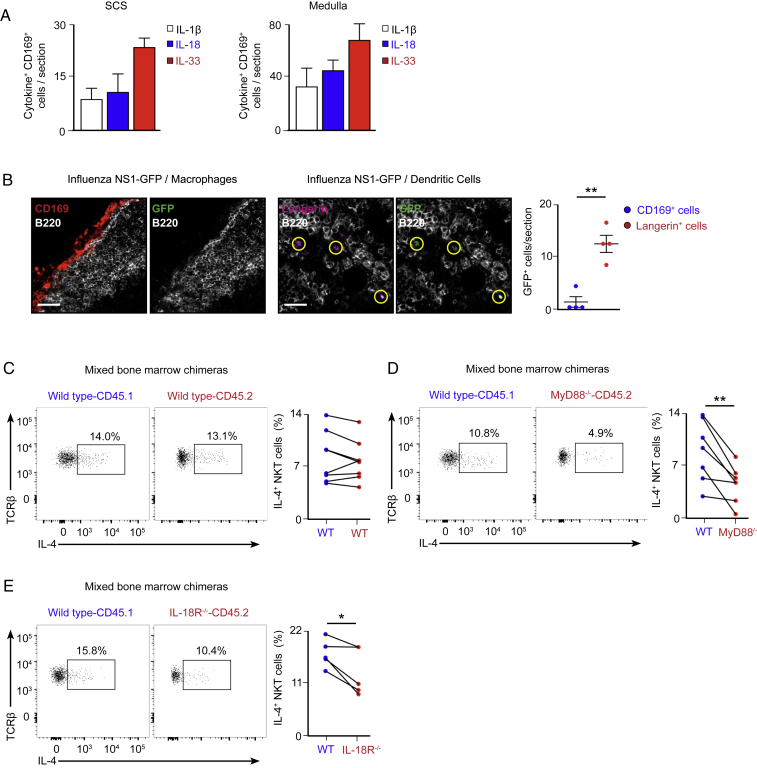
Intrinsic Role of MyD88 and IL-18R in NKT Cell Production of IL-4, Related to Figure 6(A) Quantification of IL-1β+, IL-18+ and IL-33+ cells in the SCS and medullar areas from the images shown in Figures 6C and 6D.(B) Confocal microscopy of mediastinal lymph nodes from wild type mice that were infected with 200 PFU of PR8 NS1-GFP and sacrificed after 3 days. Sections were stained with antibodies to CD169 (red), B220 (gray) and Langerin (magenta). Scale bars, 60 μm. Quantification of GFP+ cells is shown in the right chart.(C–E) Flow cytometry analysis of chimeric mice that were generated by transferring a 1:1 bone marrow mixture of wild type (CD45.1+) and (C) wild type (CD45.2+), (D) MyD88−/− (CD45.2+) or (E) IL-18R−/− (CD45.2+) to sub-lethally γ-irradiated CD45.1 recipient mice. Eight weeks after bone marrow transplant, mice were infected with 200 PFU of influenza virus and mediastinal lymph nodes were harvested after further 3 days. Flow cytometry panels show the production of IL-4 by CD45.1+ and CD45.2+ NKT cells in the different sets of chimeras. Dot graphs show the quantification of IL-4+ NKT cells in the CD45.1+ population (blue dots) and the CD45.2+ population (red dots), with lines connecting the two NKT cell subpopulation coming from the same chimera.In all panels, each dot represents a single mouse. Horizontal bars – mean; error bars – SEM. Data are representative of two independent experiments. Statistical analysis, two tailed Student’s t test, ∗p < 0.05, ∗∗p < 0.01.